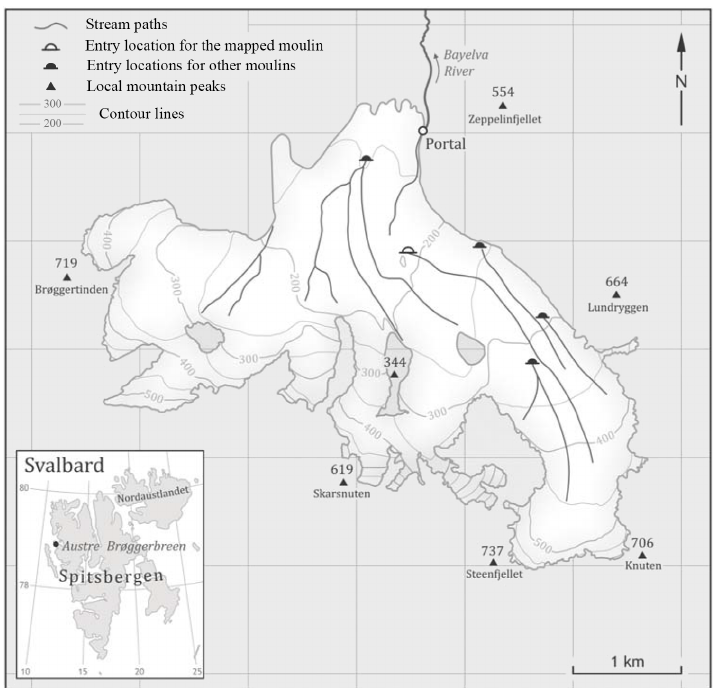
Figure 2. Location map of Austre Brøggerbreen. Contour lines are based on a 1990 elevation data set, with the glacier area according to König et al. (2013). Location of moulins and the portal, which is where the main meltwater stream emerges from within the glacier, are from autumn